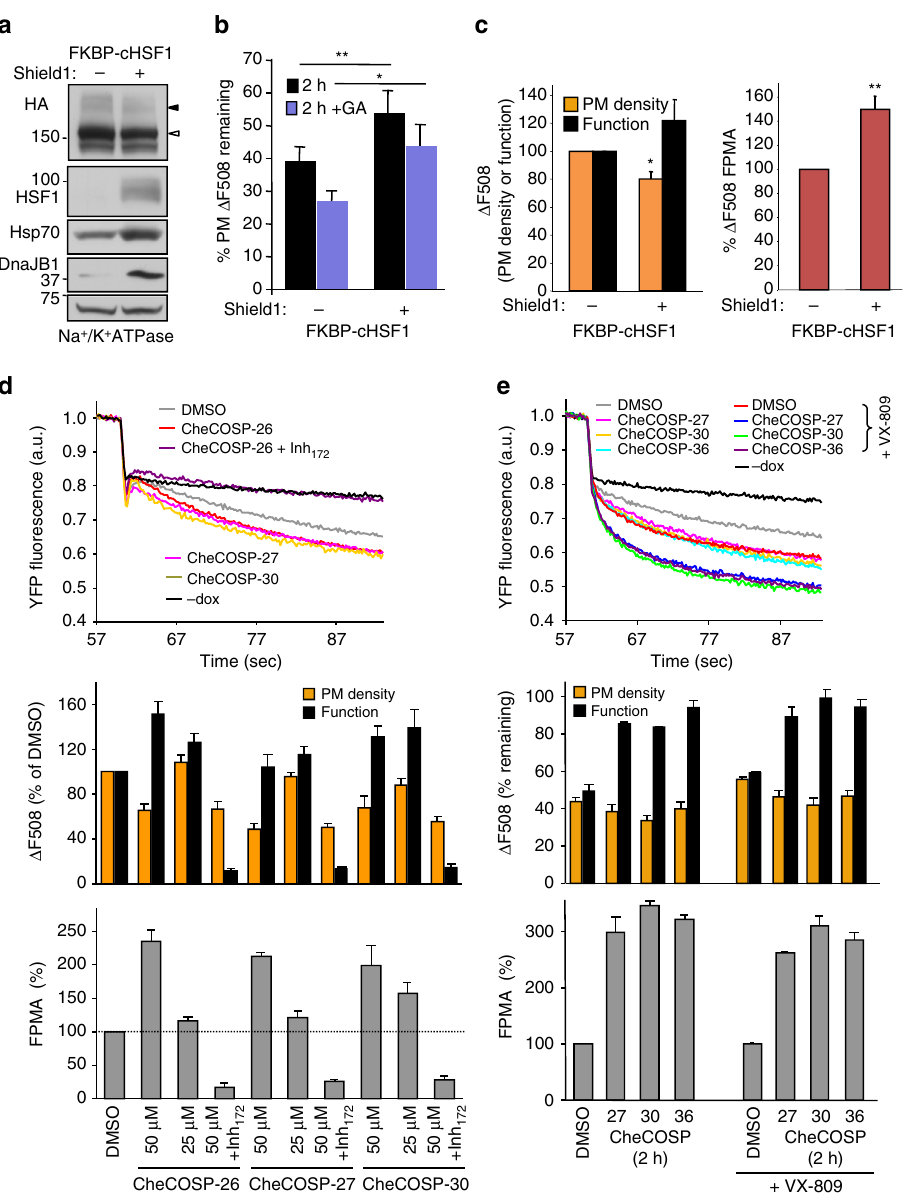
Fig. 8 Activation of the heat shock response or Hsp90 promotes Δ F508-CFTR function and stability at the PM. a Induction of FKBP-cHSF1 and the expression of Hsp70 and DNAJB1 in the presence of 0.2 µ M Shield-1 was detected by immunoblotting in HeLa cells, co-expressing Δ F508-CFTR in the presence of VX-809 (3 µ M, 37 ˚ C for 24 h). b VX-809-rescued Δ F508-CFTR-3HA was stabilized at the PM by cHSF1 induction (0.2 µ M Shield-1) in the absence or presence of GA (5 µ g ml − 1 ). The CFTR PM density was measured by ELISA after 2 h chase at 37 ˚ C ( n = 3). c The PM density, channel function and FPMA of VX-809 rescued Δ F508-CFTR-3HA were determined in the absence or presence of FKBP-cHSF1 (0.2 µ M Shield-1, 37 ˚ C, 24 h) in Hela cells and expressed as percentage of control. CFTR function ( n = 3) and PM density ( n = 3) was monitored by iodide ef fl ux assay and ELISA, respectively. d The effect of Hsp90 activators on the PM density ( n = 3) and function ( n = 3) of Δ F508-CFTR determined by PM ELISA and YFP-quenching assay, respectively. The rescued Δ F508-CFTR (26 °C, 48 h) was unfolded for 2 h at 37 °C in the absence or presence of indicated Hsp90 activators (50 μ M CheCOSP 26, 27 or 30). The lower panel depicts the FPMA of Δ F508-CFTR. e Hsp90 activation stabilizes the functional conformation of the Δ F508-CFTR. The PM turnover ( n = 3) and functional stability ( n = 3) of Δ F508-CFTR was determined as in d . The rescued Δ F508-CFTR (26 °C, 48 h) was unfolded for 30 min at 37 °C, followed by the activation of Hsp90 (50 μ M CheCOSP 27, 30 or 36) during the CHX chase (2 h, 37 °C). VX-809 (3 μ M, 24 h) was included as indicated. Data are means ± SEM. * P < 0.05 or ** P <